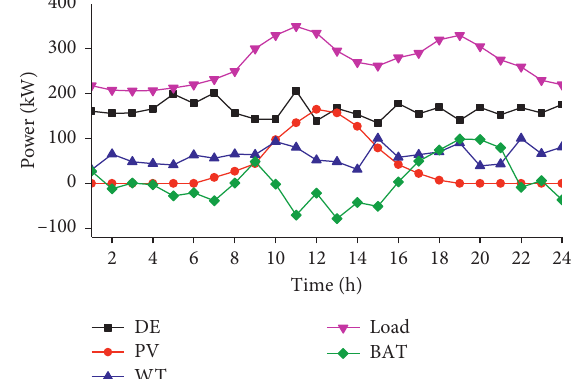
Figure 9: Output power of generation units at the minimum economic and environmental cost.